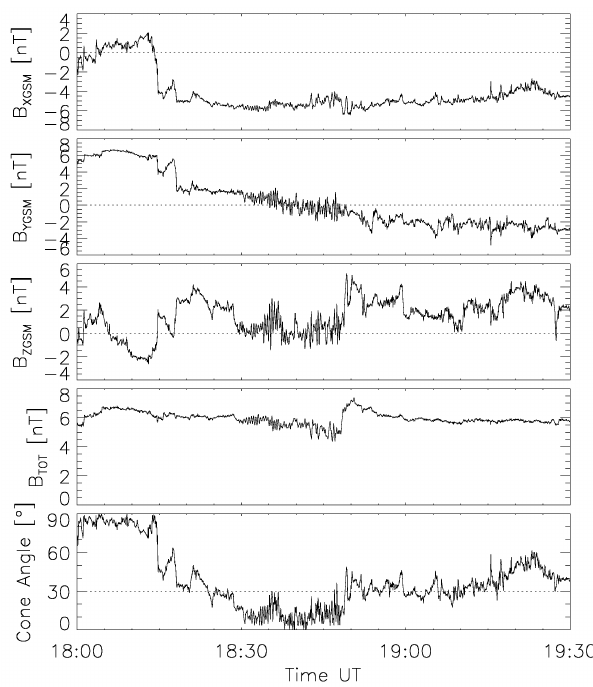
Fig. 1. IMF measured by the MAG instrument onboard Geotail in GSM coordinates on 5 September 2002. The bottom panel shows the IMF cone angle θ xB